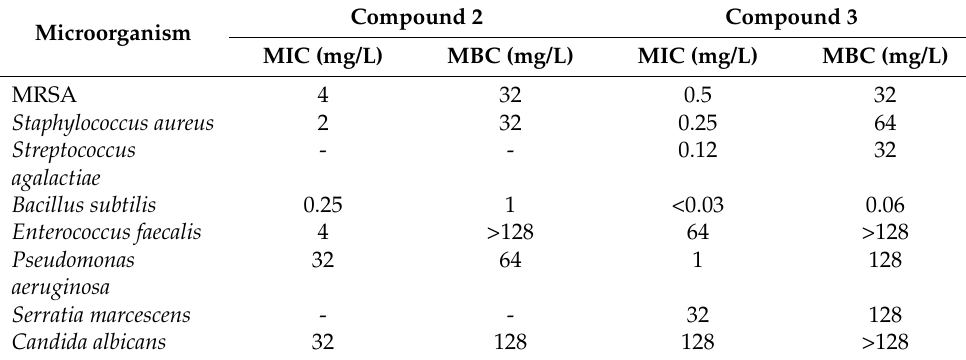
Table 4. Antimicrobial activity spectrum of compounds 2 and 3.